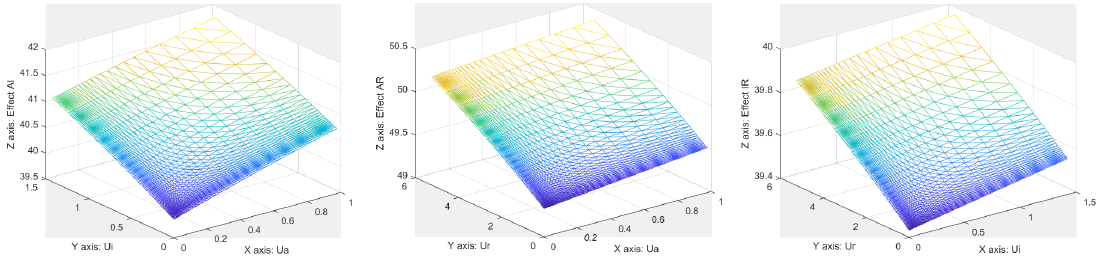
Figure A4. Surface responses obtained for γ = 0.5 for each drug combination.